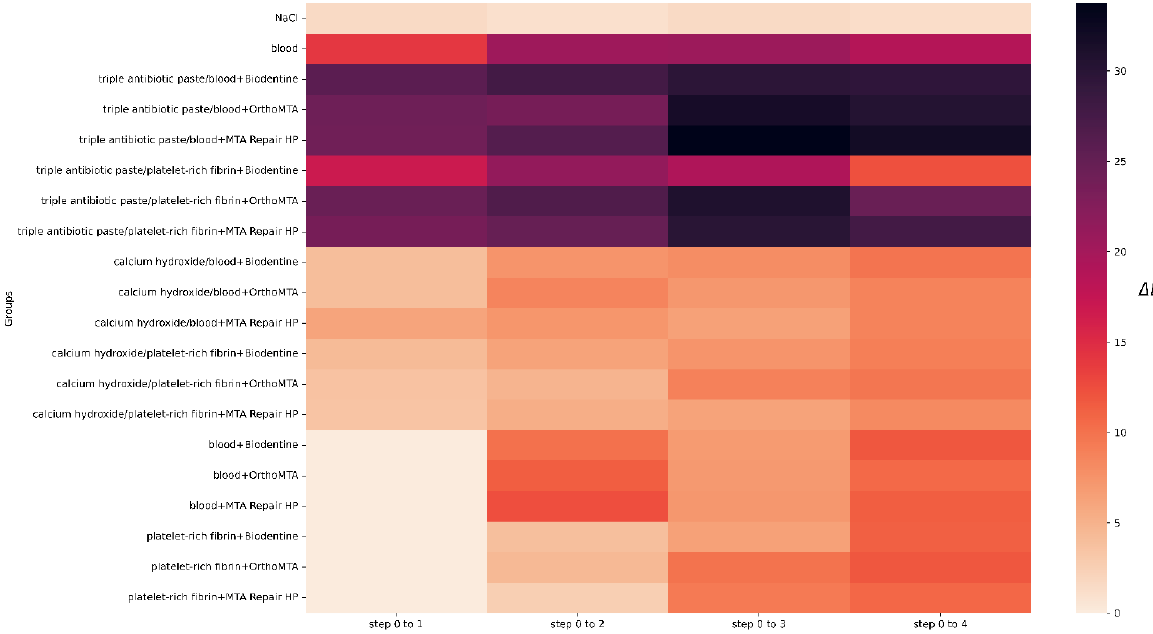
Figure 3. Lightness level distribution of the VITA SYSTEM 3D-MASTER for each step.